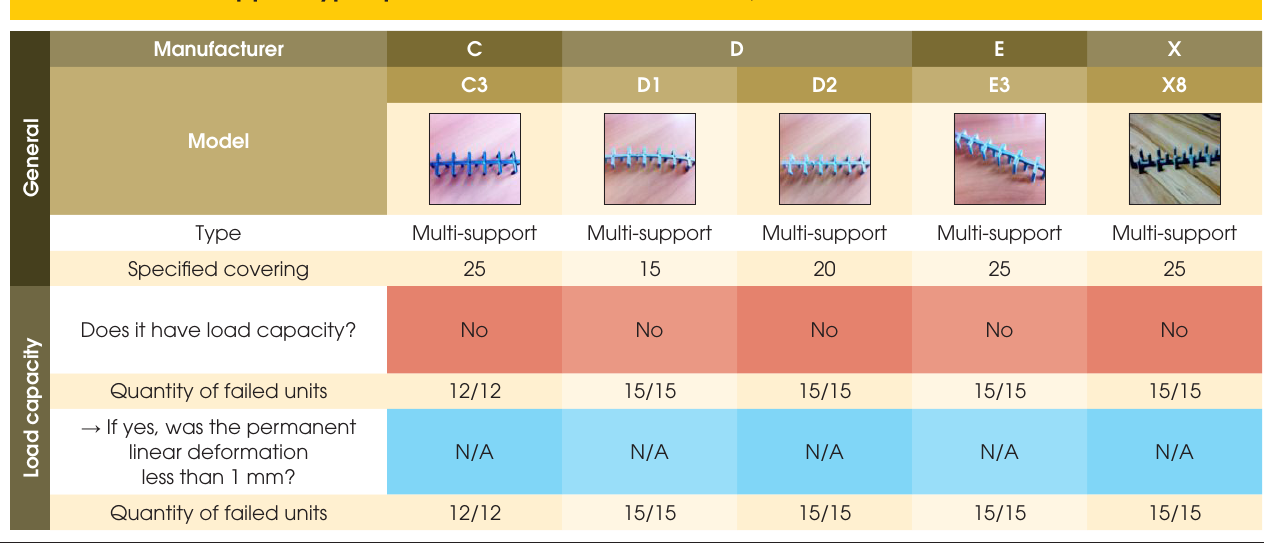
Table 22 – Results of the load capacity requirement evaluation of